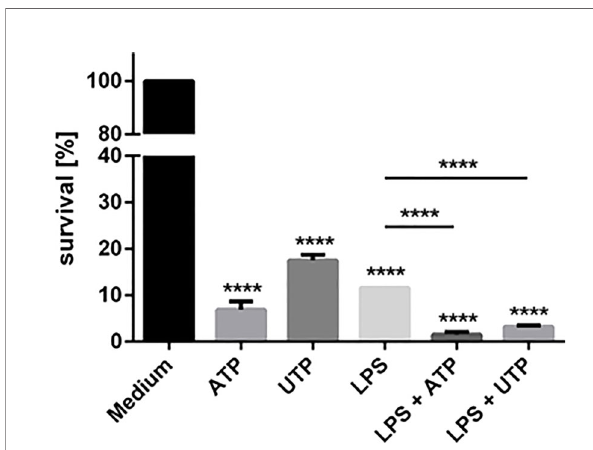
FIGURE 4 | The effect of extracellular ATP and UTP on the intracellular killing of Leishmania donovani parasites by neutrophils. Primary human neutrophils were infected with L. donovani promastigotes (ratio 1:10) for 3 h at 37°C, 5% CO 2 . The infection rate was controlled on Giemsa-stained cytocentrifuge slides. After removing the free, non-ingested parasites the infected cells were treated with ATP, UTP, LPS and the combination of LPS with ATP or UTP or left untreated (medium). After 18 h of incubation at 37°C, 5% CO 2 the survival of L. donovani parasites was determined by using a limiting dilution assay. The bars show % of viable Leishmania compared to untreated neutrophils ± SD (n=3). Statistical analysis by ordinary one-way ANOVA with a post hoc Turkey ’ s test. Asterisks above the bars indicate signi fi cance compared to untreated cells. ****p ≤ 0.0001.